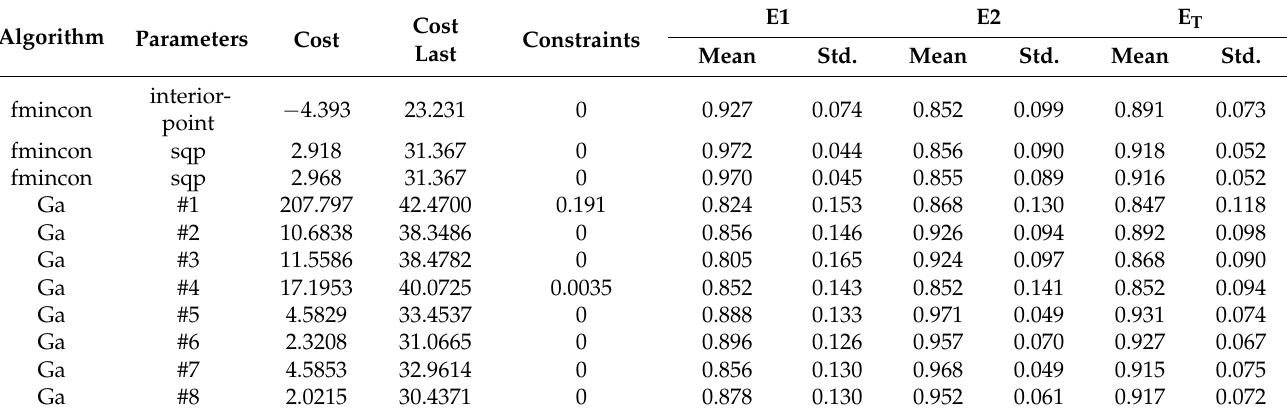
Table 5. The best efficiencies given by optimizers. Best values are highlighted in